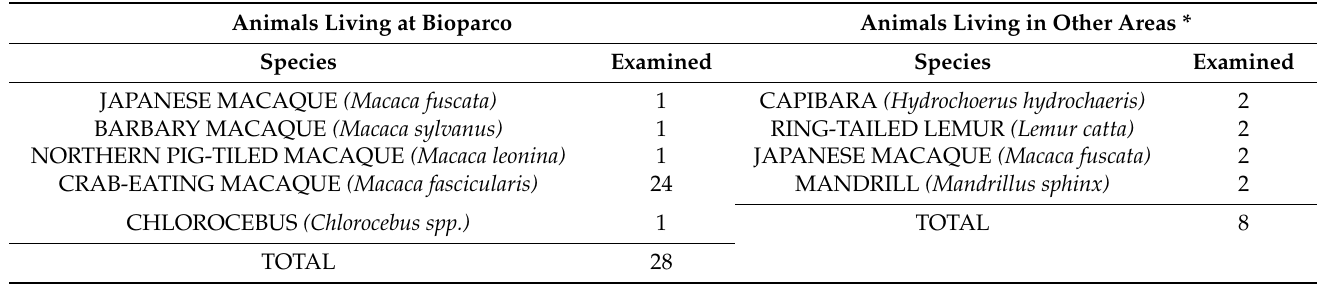
Table 4. Sera analysed by IFA.